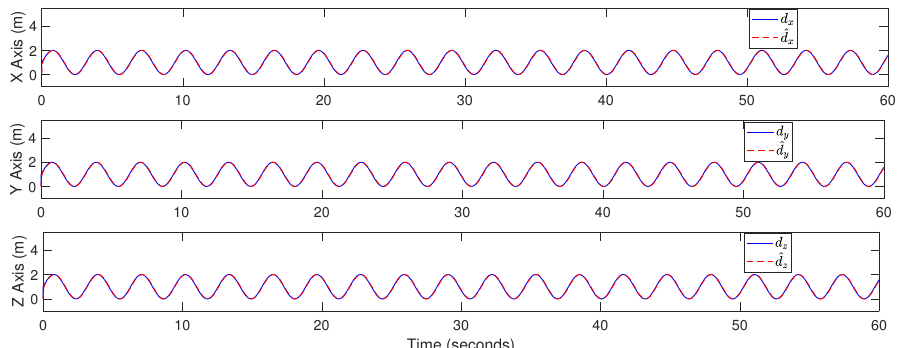
Figure 13. Disturbance observer outcome for position subsystem with periodic